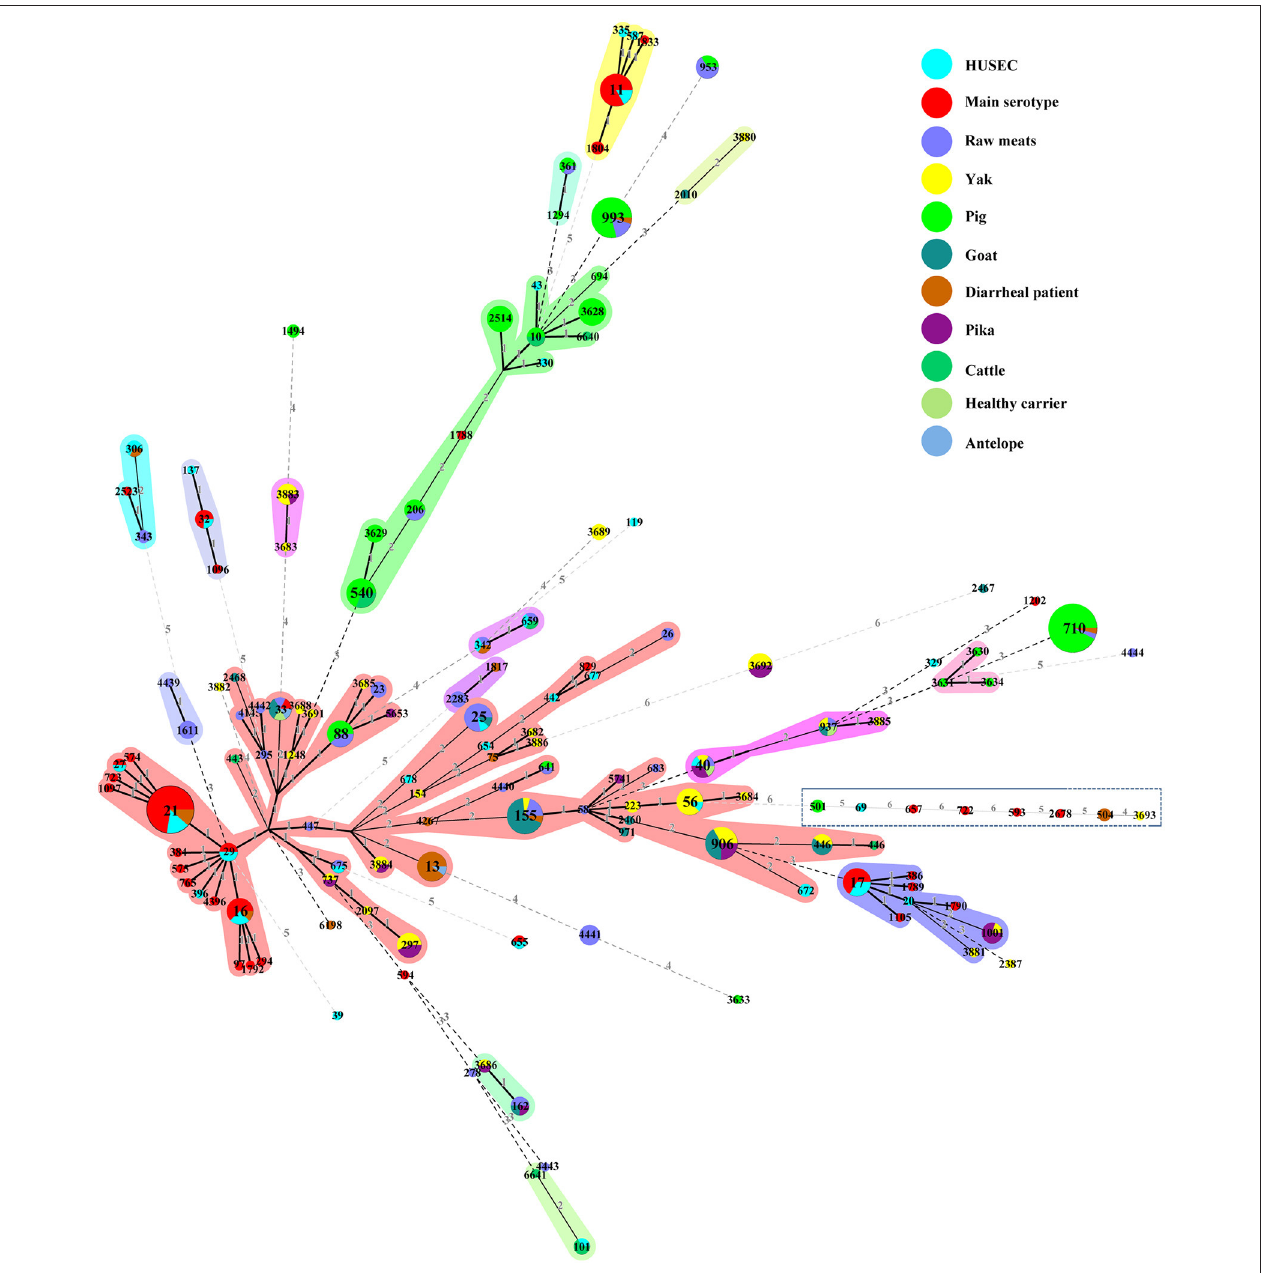
FIGURE 2 | Minimum spanning tree of 94 STs from this study, 32 STs from the HUSEC collection (blue), and 36 STs from human STEC STs of serogroups O26, O45, O103, O111, O121, O145, and O157 in the E. coli MLST database (red). Each circle represents an ST with the size being proportional to the number of isolates. The colors for the slices of the pie represent the sources of the isolates (see labeling in the upper right corner). The numbers on the connecting lines represent the number of allelic differences between two